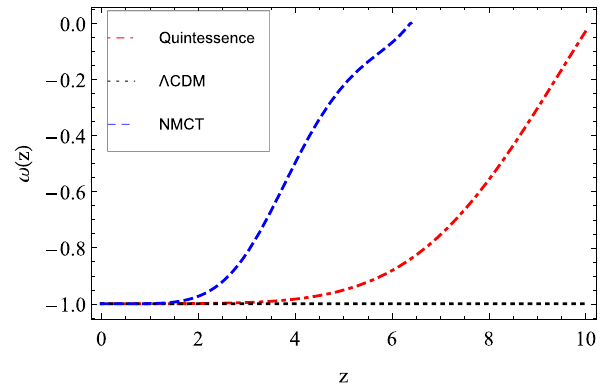
Fig. 1 The behavior of EoS parameter ω( z ) versus the redshift for the Λ CDM , quintessence and non-minimally coupled tachyon models